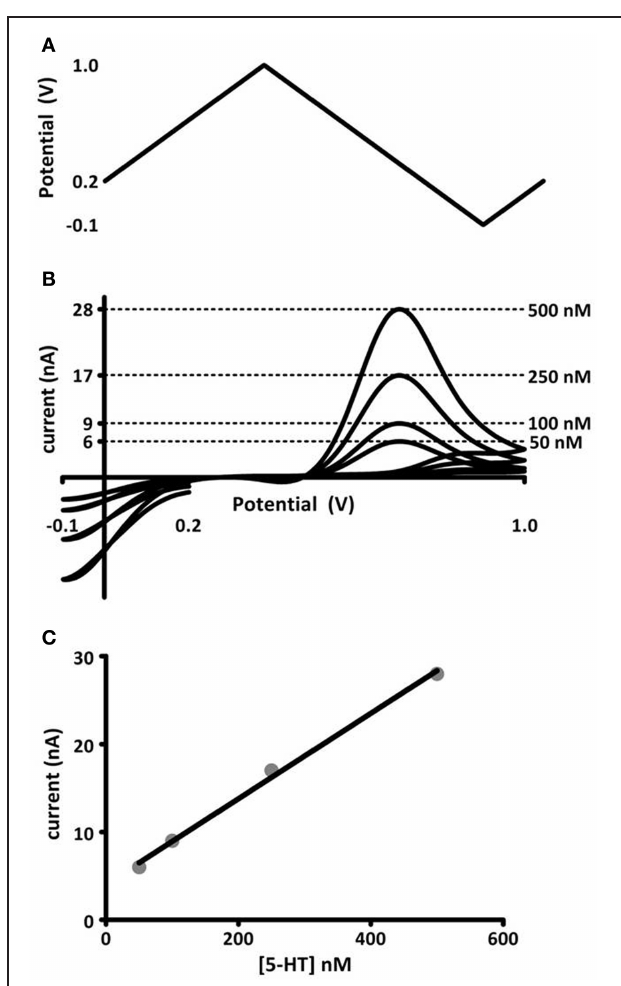
FIGURE 1 | In vitro calibration of microelectrodes. (A) Voltage potential waveform, described by Jackson et al. (1995), for detection of serotonin. (B) Cyclic voltammograms (current-voltage curves) obtained for known concentrations of serotonin injected into a flow cell apparatus. The concentration (right) and its corresponding oxidation current amplitude (left axis) are noted by dashed lines. (C) Maximal oxidation current vs. concentration of serotonin. The data are fit to a linear regression (black line), the slope of which gives a calibration factor for serotonin measured at these